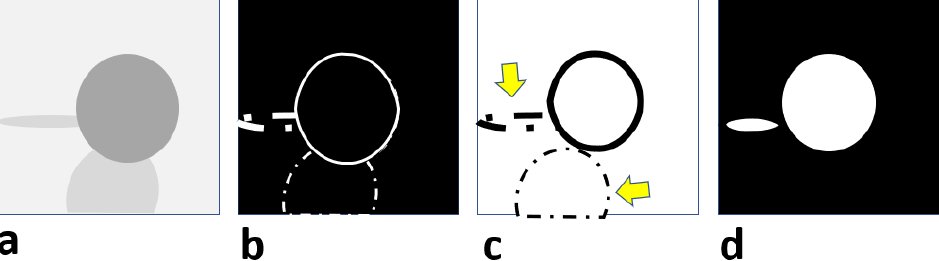
Figure 4. Schematic of the morphological construction of a solid-type inclusion from the greyscale image where, ( a ) represents the solid-like inclusion, ( b ) the inclusion after edges detected, ( c ), the image was complimented and, ( d ), the inclusion morphology retained after removal of major arti- facts.